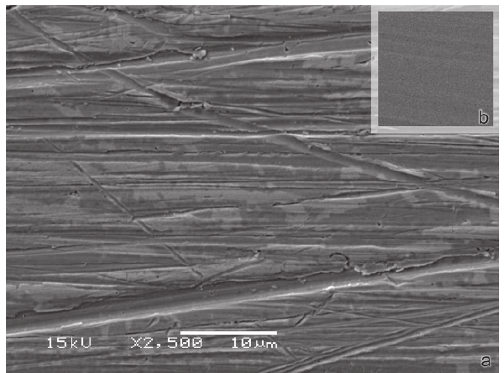
Figure 12. SEM picture of the anodic platinum electrodes after experiment 5f (a, 50 g L -1 , 9 kV, 0.75 mA). The insert (b) shows the surface of the clean cathode as comparison (same